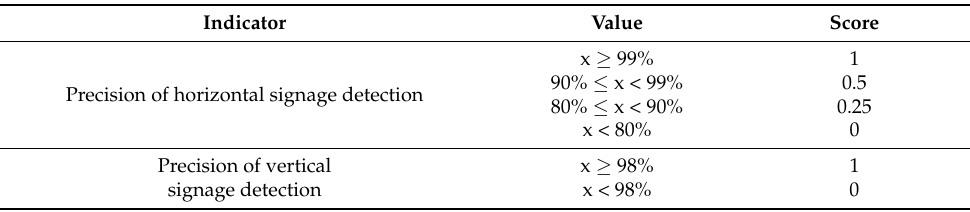
Table 5. The assessment framework—machine-readable signage area. Indicator